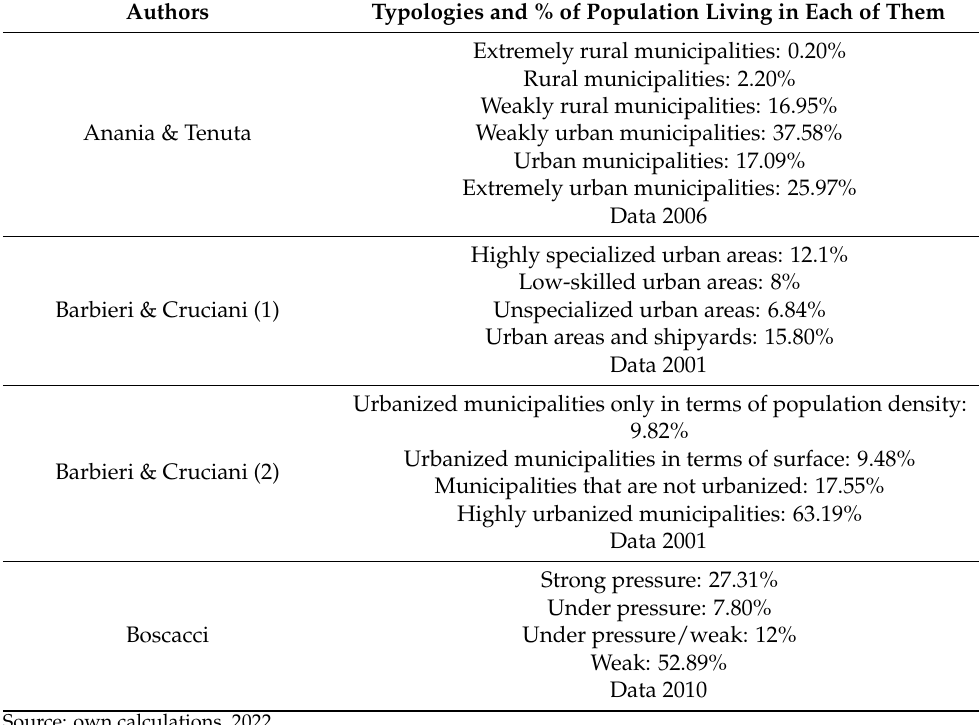
Table 3. The % of population living in each territorial